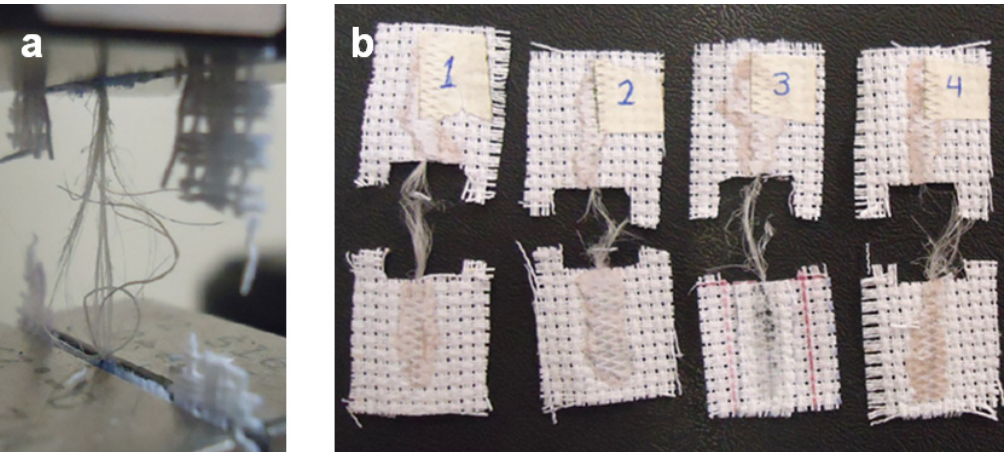
Figure 8- Macrofibre rupture process during the test (shredding) a); Defibrillated macrofibres after test